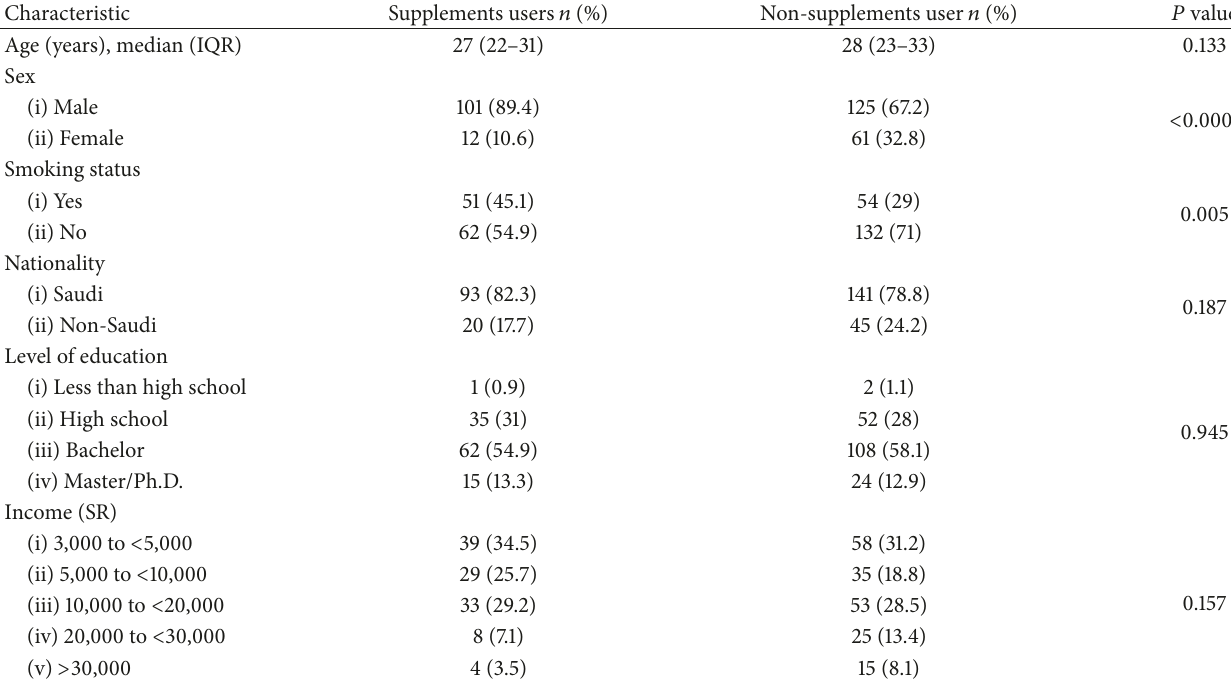
Table 1: Demographic characteristics of participants.